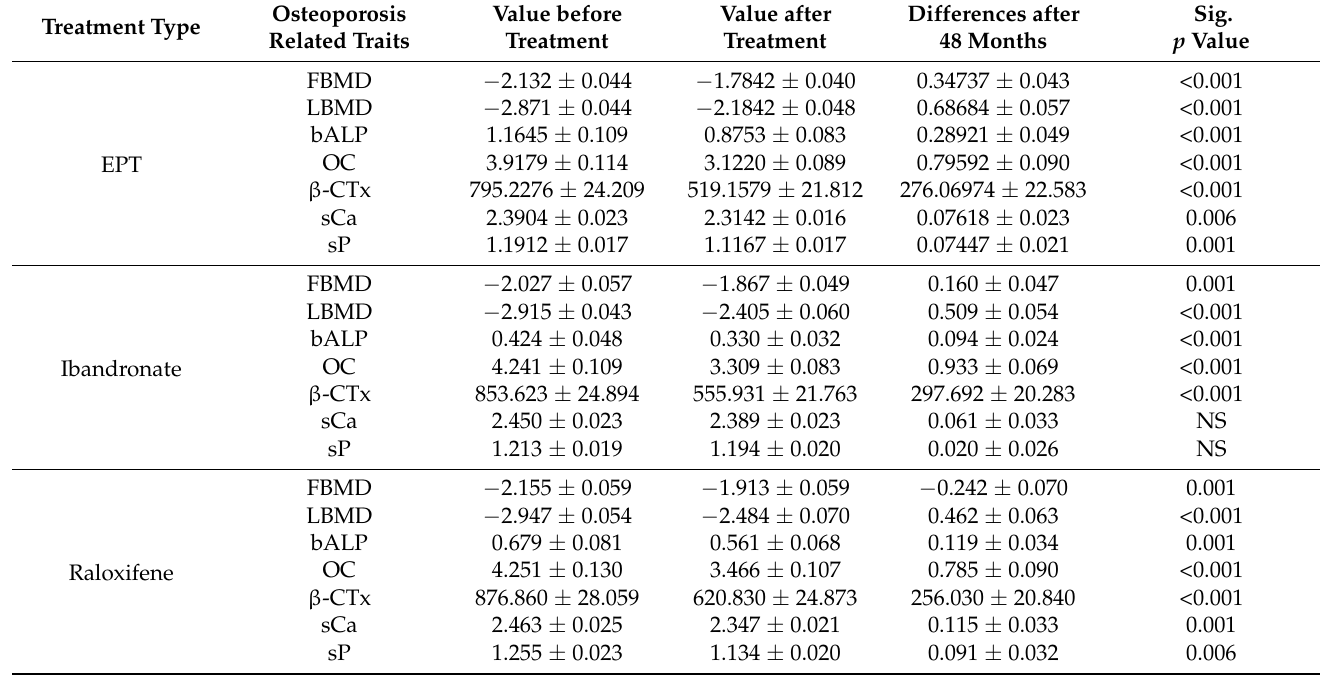
Table 6. The effect of treatment types on osteoporosis-related traits.